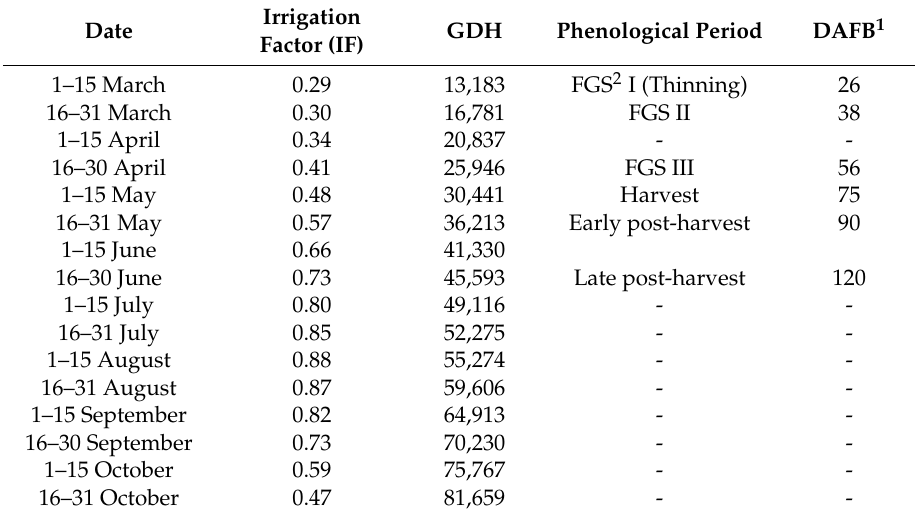
1 DAFB: days after full bloom (occurring 9th February = 40th day of the year). 2 FGS: Fruit growth stage.